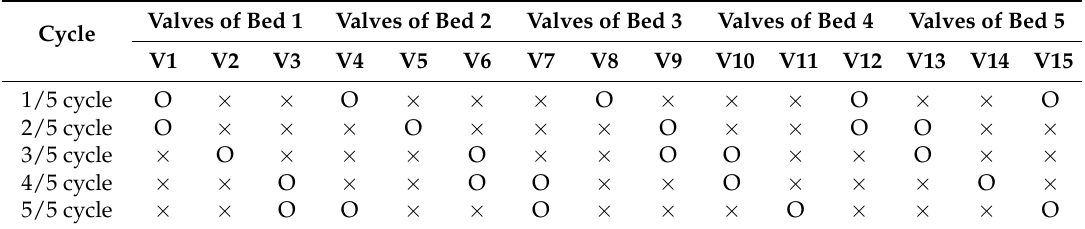
Table 1. Valve-switching schedule for the multibed TFRR.